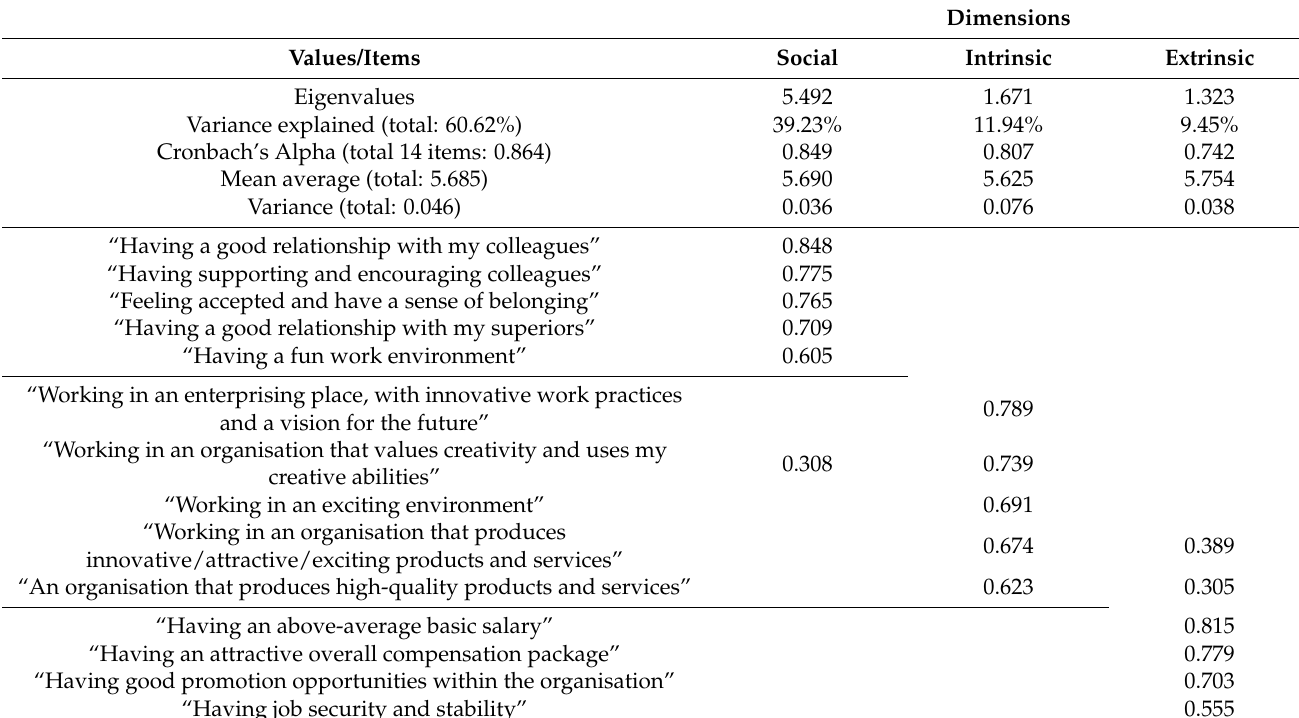
Table 2. Work values factors (PCA with a subsample of 300).